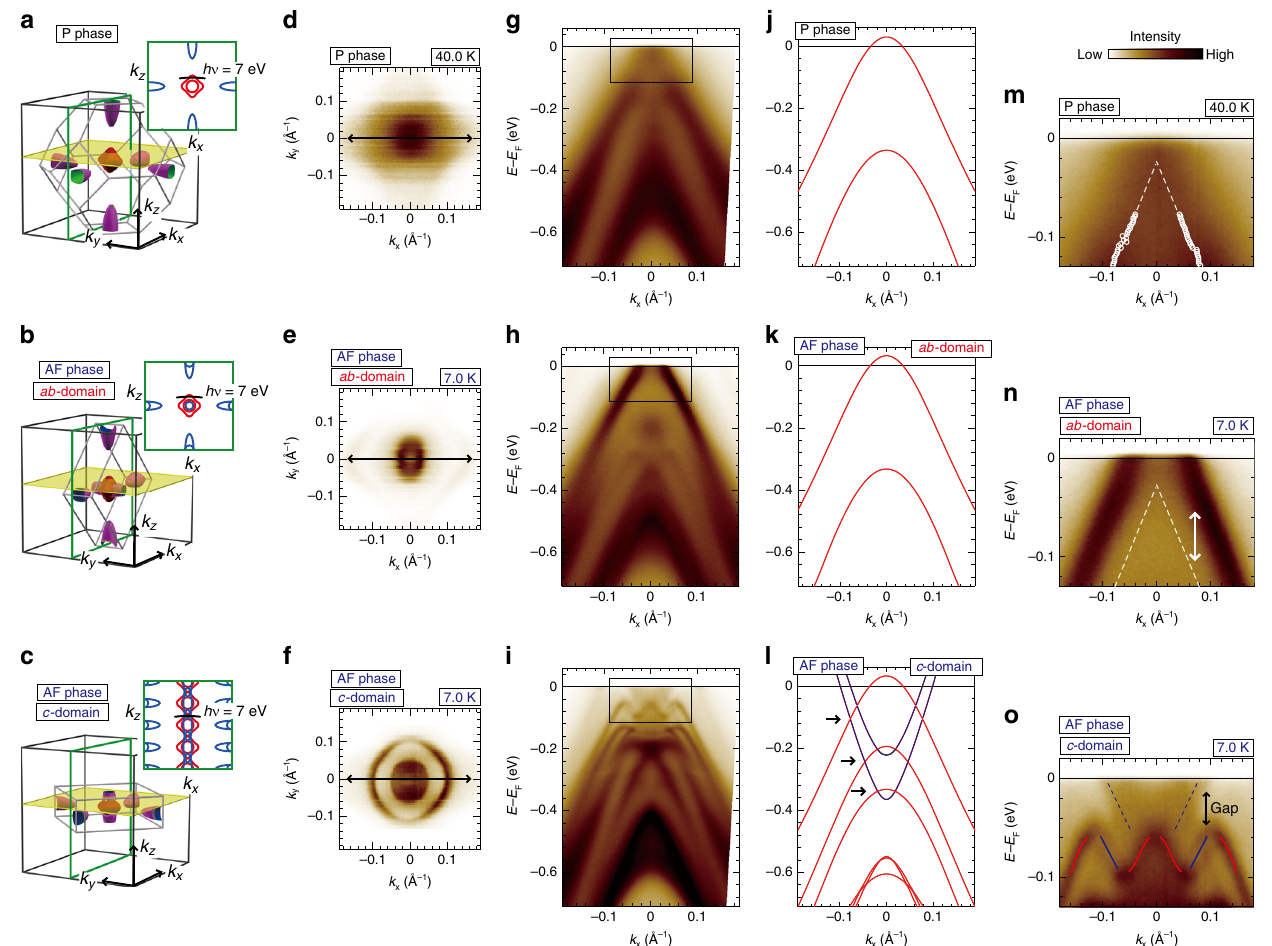
Fig. 3 Dramatic electronic reconstruction of ordered CeSb in AF phase. a Three-dimensional FSs for P phase, and the folded one for b ab - and c c -domain according to the AF modulation ( q = 1/2). The yellow-colored planes correspond to the k x − k y sheets at k z = 0.2 Å − 1 detected by our laser- ARPES with h ν = 7 eV (Supplementary Fig. 2). The insets schematically illustrate (red line) the hole and (blue line) electron pockets in k z − k x plane (green frames in a – c ) with (black line) the k x cut line at k z = 0.2 Å − 1 for our laser-ARPES. The FS maps experimentally observed at d 40 K (P phase) and 7.0 K (AF phase) for different domains, e ab - and f c -domain, which were taken at the different positions of the same cleaved surface. In d , we also observe the blurred photoelectron intensity outside the main signal due to the k z broadening effect 14,51 . g – i The E − k x maps cut along the k x line denoted by arrows in d – f . j – l The DFT bands cut along the comparable k x line with g – i . The DFT bands in AF phase were computed with the backfolding of the bands of P phase into the deduced BZ (see b , c ). The overall bands are shifted in energy with − 0.1 eV 14 to compare the experimental results. The dispersions of the hole and electron bands are indicated by red- and blue-colored lines, respectively. The arrows in l highlight the band crossings which allow the hybridization. m – o The magni fi ed laser-ARPES images within the E − k x windows indicated by rectangles in g – i . In m and n , the band dispersion for P phase (dashed lines) was deduced by the peak position of the momentum distribution curves (circles in m ). In o , the dispersions of the hole and electron bands are guided by red and blue lines,